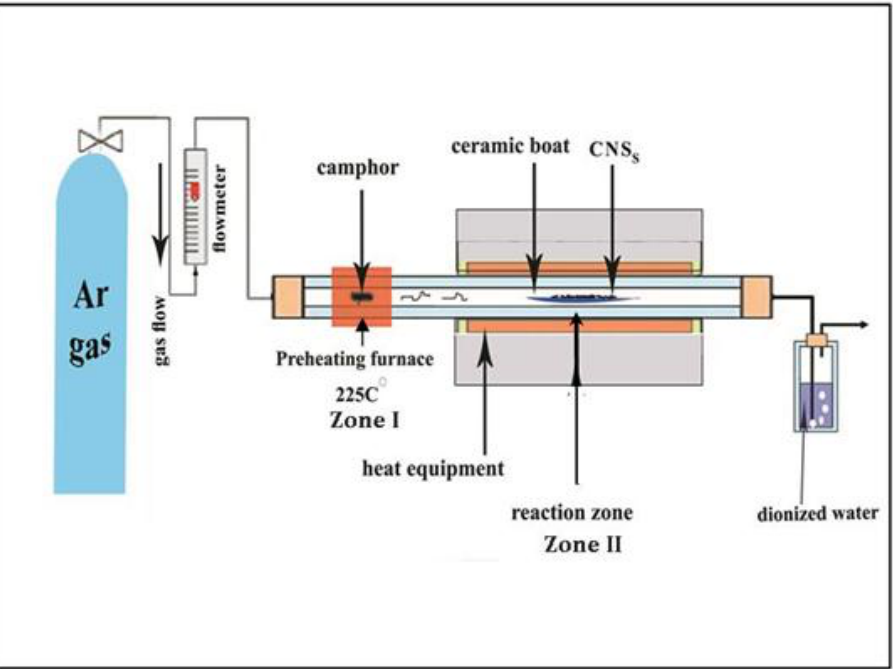
Fig. 1: The schematic experimental setup for the synthesis of CNSs.